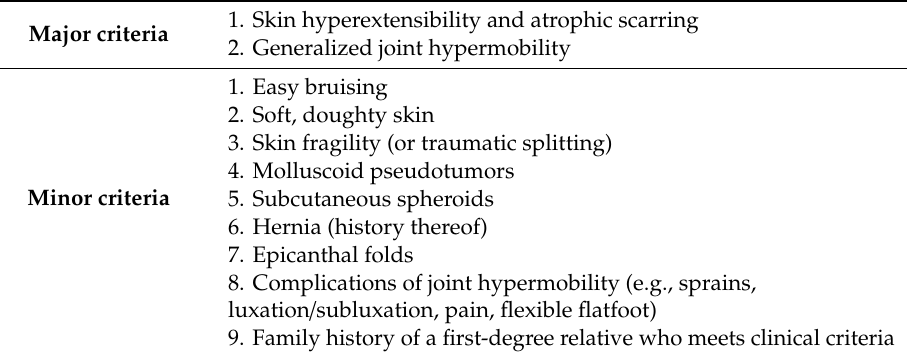
Table 2. Classical Ehlers–Danlos syndromes (EDS)–clinical